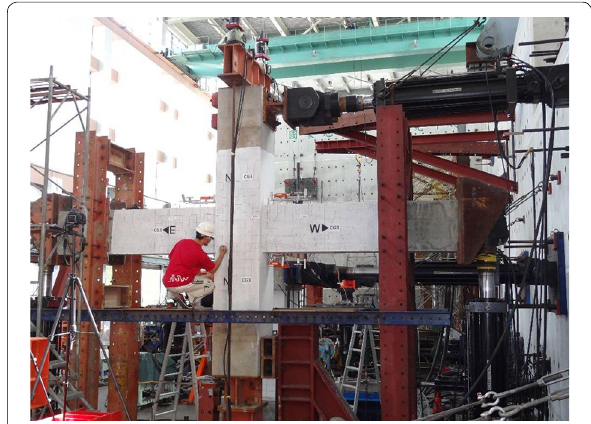
Fig. 9 Typical test setup for cruciform beam‑column joints at the NCREE laboratory.